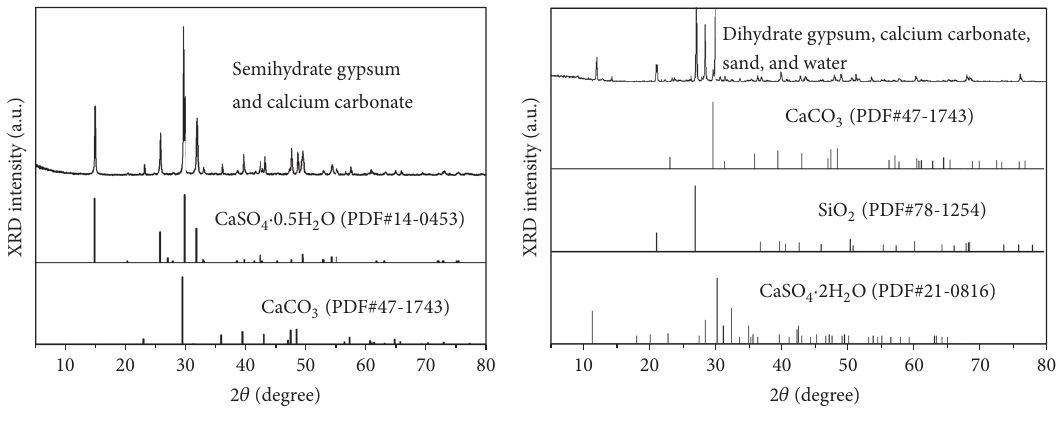
Figure 5: XRD spectra of the gypsum-cemented similar material before and after hydrate